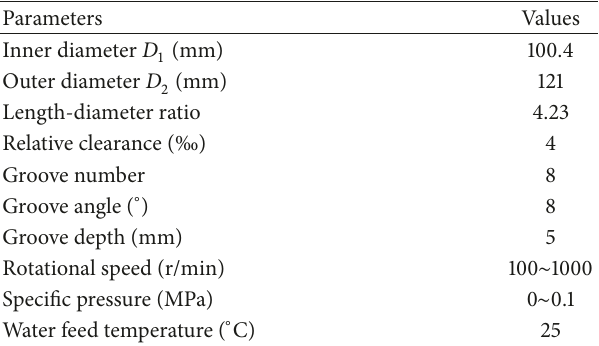
Table 1: Physical parameters of the rubber